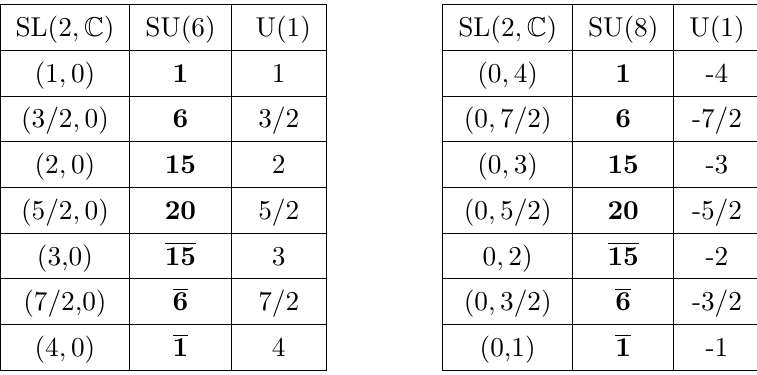
Table 7 . The irreducible chiral doubleton supermultiplets of SU(2 ; 2 j 6) and its conjugate, with the highest spin 4. Vectors here are singlets of SU(6) and scalars are